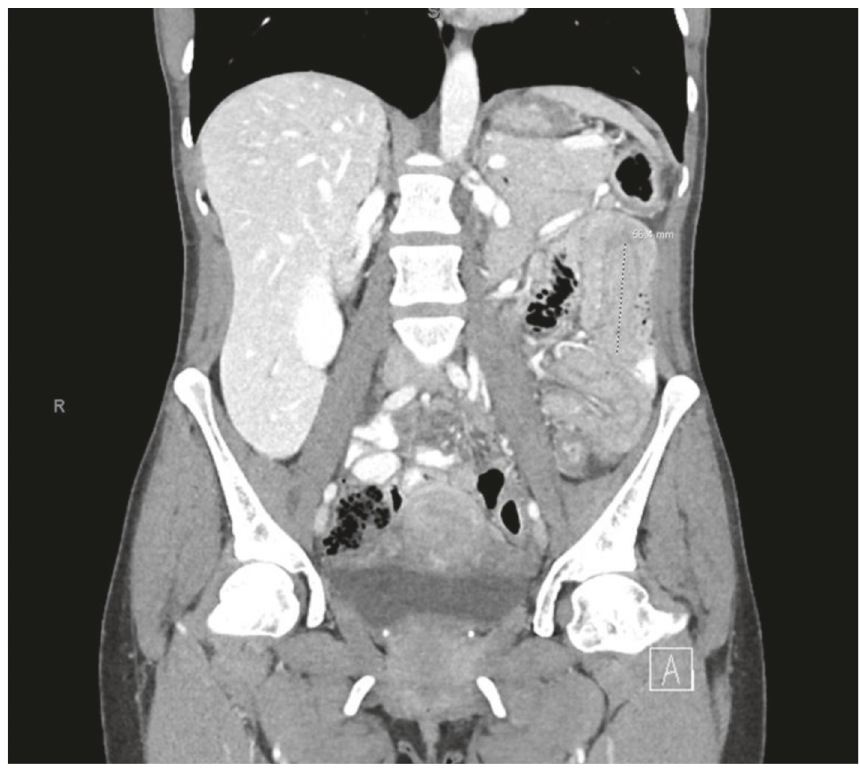
Figure 1: CT scan showing intussusception in the left hemiabdomen.